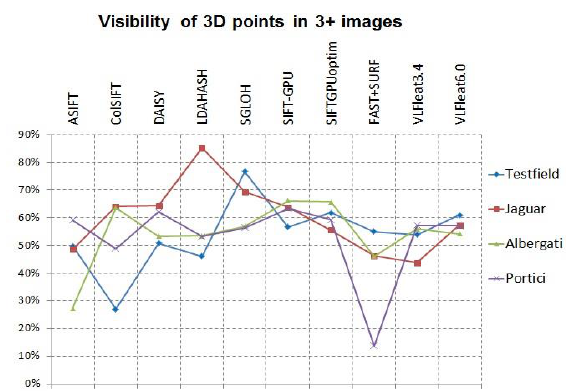
Figure 5: The visibility of the derived 3D points in more than 3 images (normalized with respect to the all extracted points).